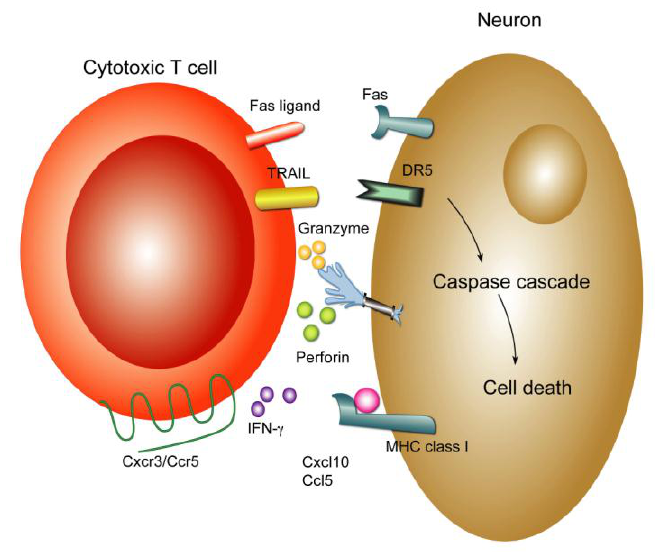
Figure 3. Mechanisms of CD8 + T cell clearance in the CNS. CD8 + T cells control WNV infection in the CNS through multiple mechanisms. Infected neurons upregulate surface expression of MHC class I molecules. Antigen-specific CD8 + T cells recognize infected neurons via class I MHC and processed viral peptides and trigger cell death of target